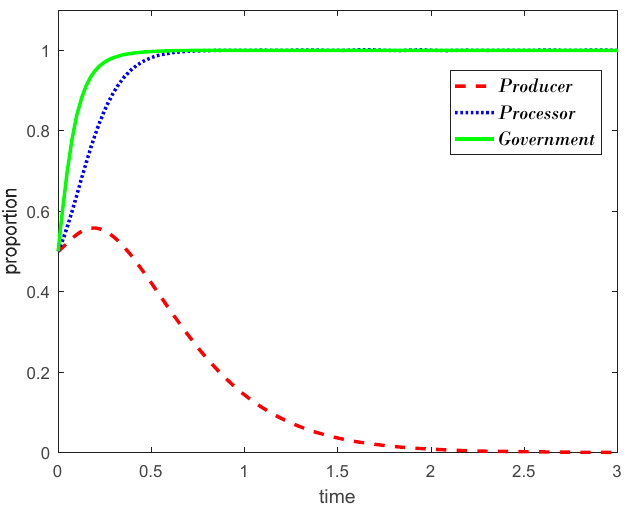
Figure 5. The evolutionary path of case 3.